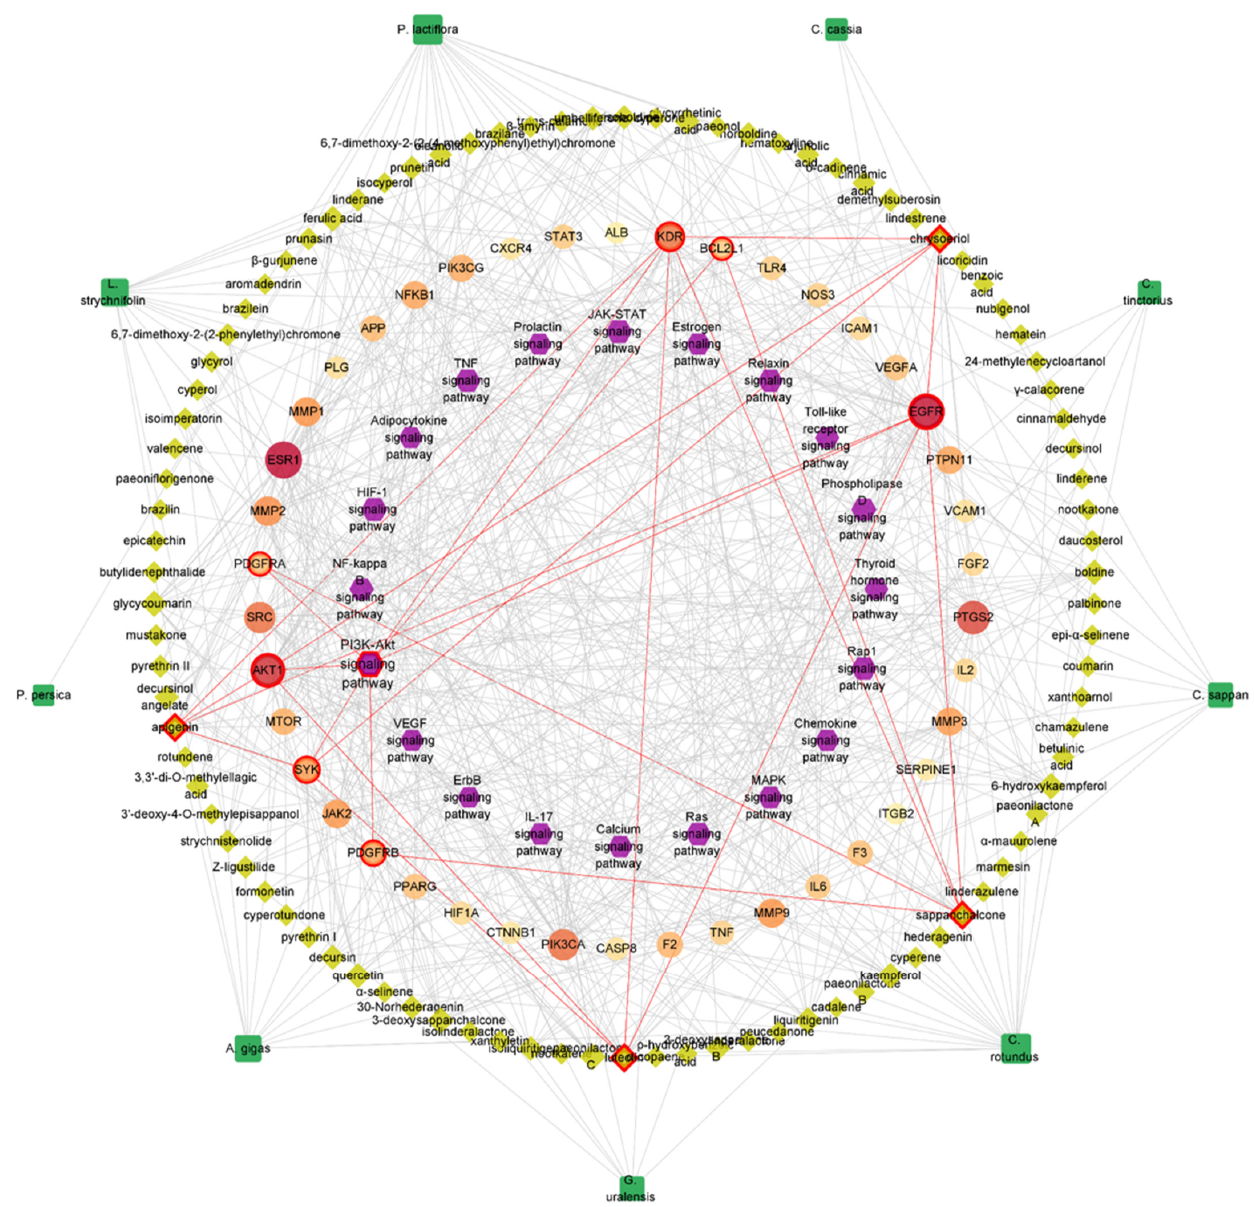
Figure 4. Integrated H-C-T-P network. Table 2. List of key components of Dangguisu-san from the H-C-T-P network analysis.